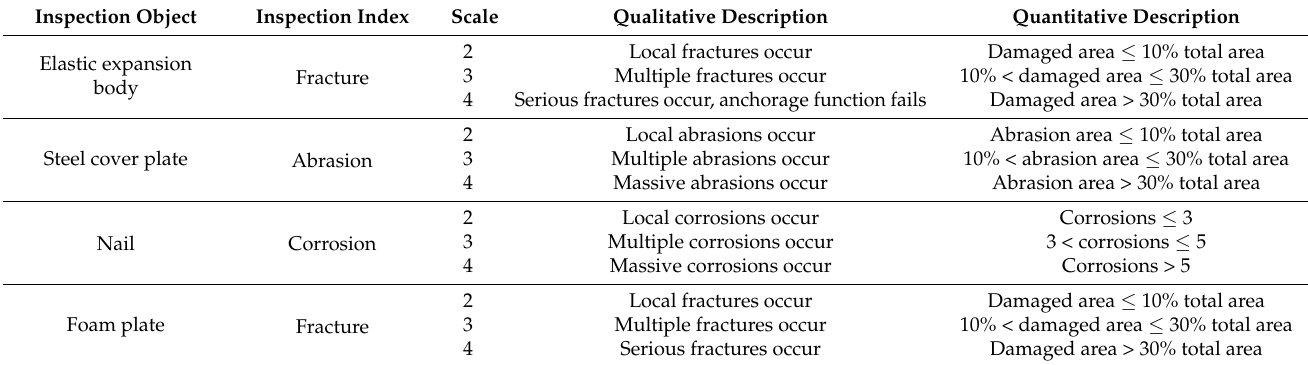
Table 6. Inspection index evaluation of the BECI of seamless